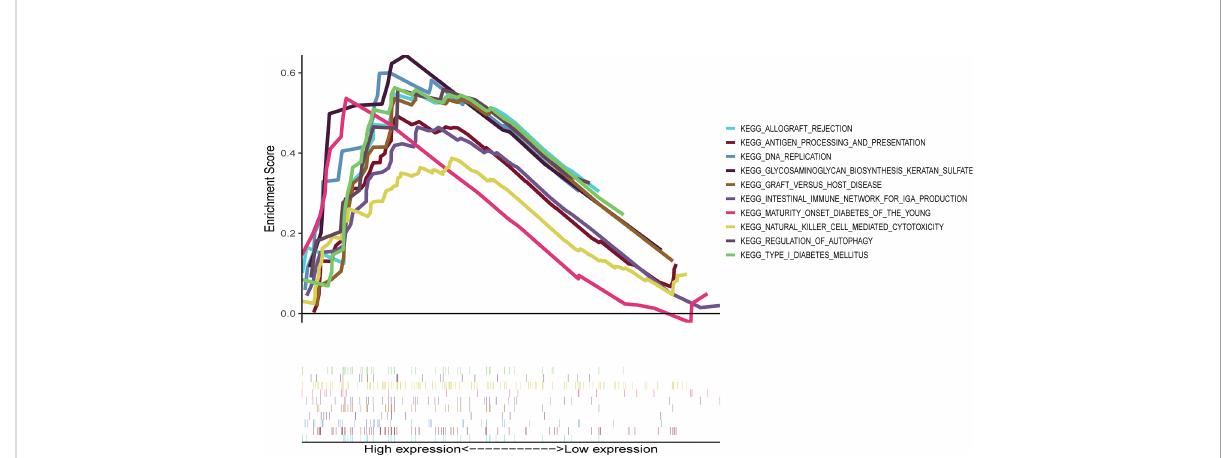
FIGURE 6 Representative results of KEGG enrichment analysis in the whole cohort. The KEGG analysis was conducted by GSEA, indicating that the top 10 active pathways in high-risk group were allograft rejection, antigen processing and presentation, DNA replication, glycosaminoglycan biosynthesis keratan sulfate, graft versus host disease, intestinal immune network for IgA production, maturity- onset diabetes of the young, natural killer cell- mediated cytotoxicity, regulation of autophagy, and type I diabetes mellitus. KEGG, Kyoto Encyclopedia of Genes and Genomes; GSEA, Gene Set Enrichment